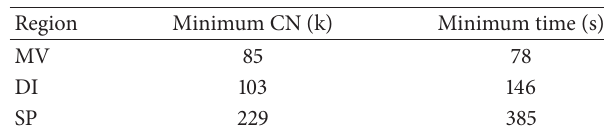
Table 3: Cost for the simulation of each